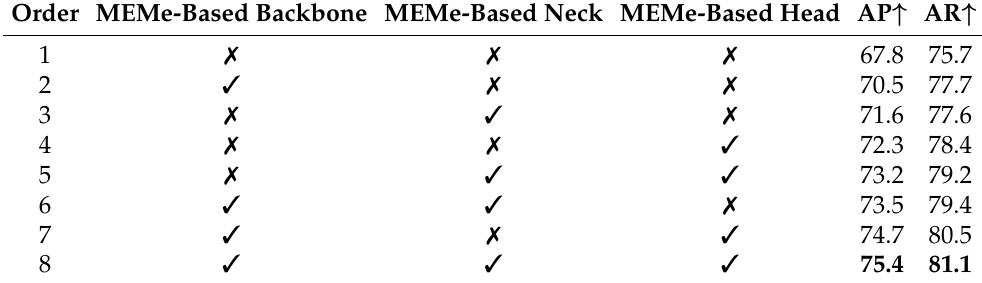
Table 1. The AP and AR of ablation models on the COCO val set with the input size of 256 × 192.